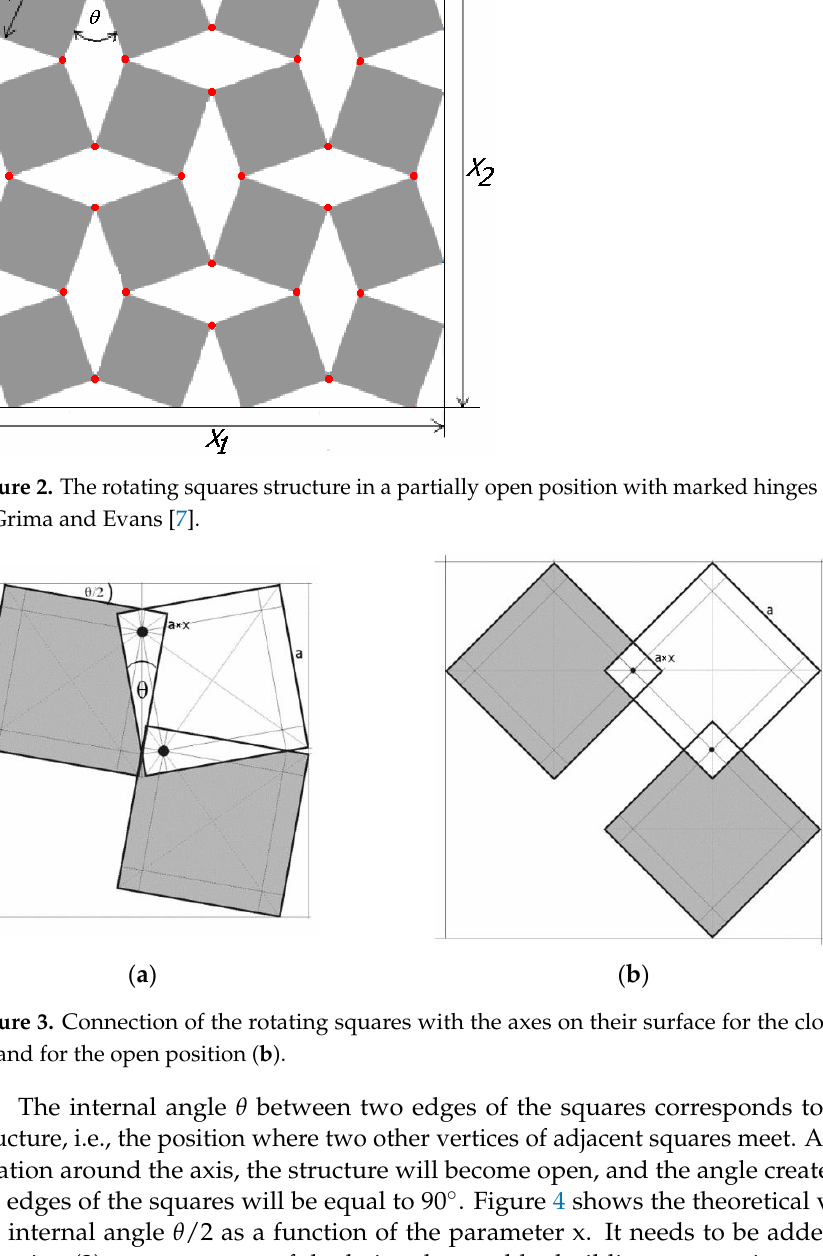
Figure 3. Connection of the rotating squares with the axes on their surface for the closed position ( a ) and for the open position ( b ).